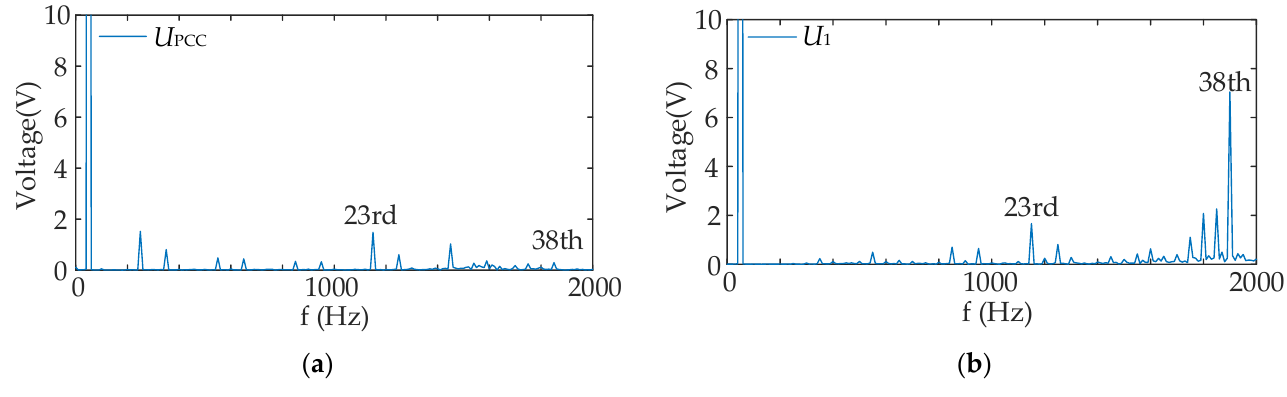
observe that the high-frequency resonance is excited in Figure 15b, which is also consistent with changing the participation factor of the node. When the 23rd harmonic current is injected, both the PCC and the inverter node can excite the low-frequency resonance, and the corresponding participation factors are 0.2270 and 0.3865, respectively, which are consistent with the excitation degree of the low-frequency part in Figure 15.